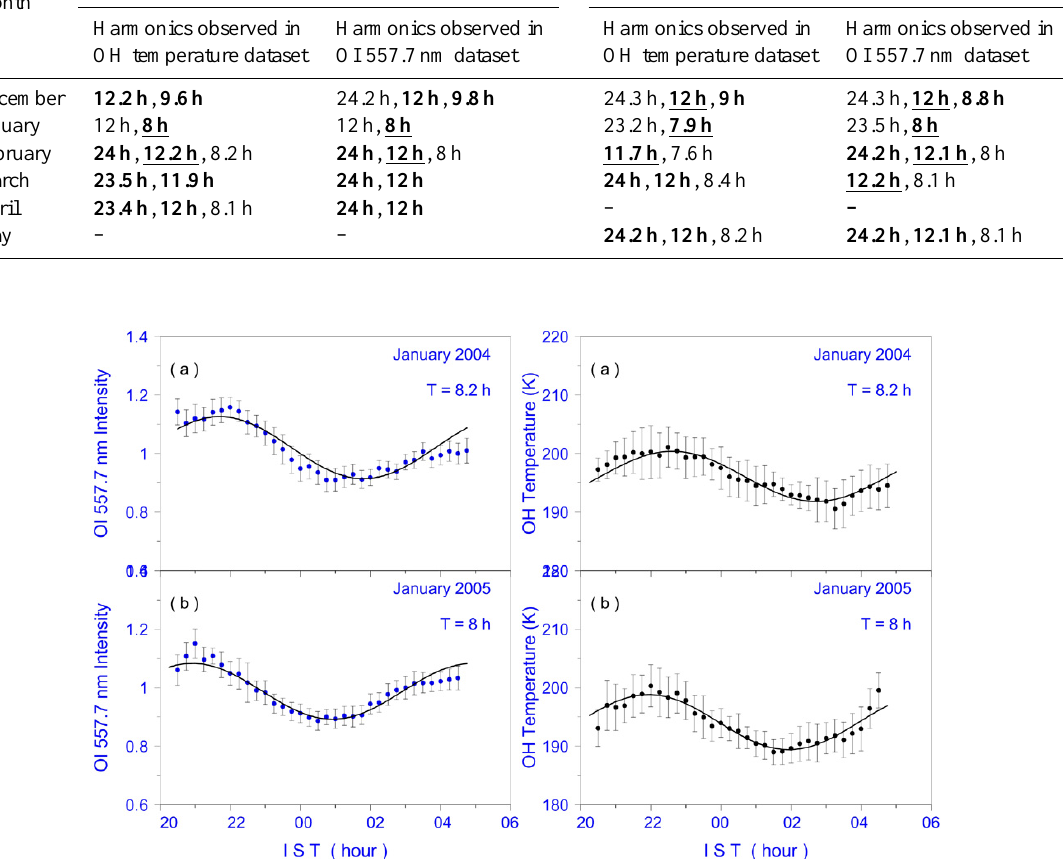
Fig. 6. Averaged variation of OI 557.7 intensity and OH temperature during January 2004 and January 2005. The error bars represent the standard deviation of the averaged values at a particular time, and the solid curves represent the sinusoidal least square terdiurnal fit (confidence level of 95%) of the form A sin [ ( 2 π/T )(t − φ) ]